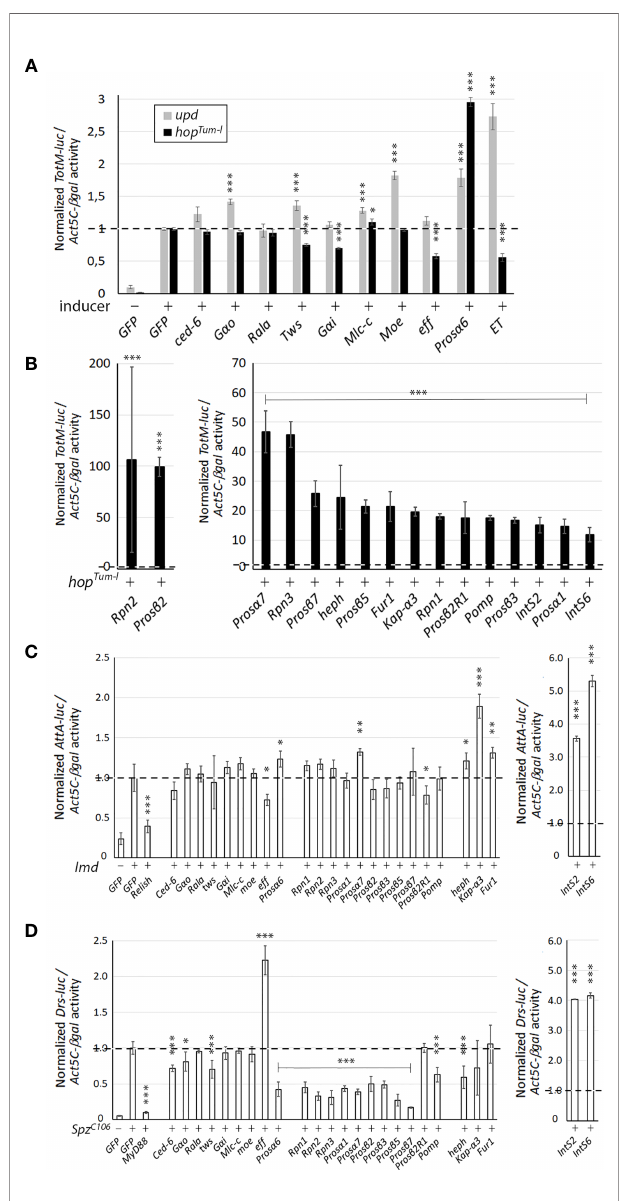
FIGURE 1 | The effect of RNAi of the putative JAK/STAT pathway regulators on the Drosophila immunity pathways. (A) The effect of RNAi of putative ET interaction partners identi fi ed in the mass spectrometry study on the activation of the JAK/STAT pathway. The JAK/STAT pathway was induced by overexpression of Upd1 (gray bars) or hop Tum-l (black bars) and the activation of the TotM-luc reporter was measured. (B) RNAi of the negative regulator candidates from the genome-wide screen in S2 cells causes hyperactivation of the pathway induced by overexpression of hop Tum-l . (C) The effect of RNAi against the candidate genes identi fi ed in A and B on the Imd-induced Imd pathway reporter ( AttA-luc ) activity. (D) The effect of RNAi against the candidate genes identi fi ed in A and B on the Spz C106 -induced Toll pathway reporter ( Drs-luc ) activity. In all reporter assays, n=4 per dsRNA treatment, and luciferase reporter values were normalized to the values of the Act5C- b gal reporter activity. The relative reporter activity value of cells with an activated pathway treated with the negative dsRNA control (GFP) is set to 1. Statistical analyses were carried out using Student t test for two samples assuming equal variances. *p, 0.05, **p, 0.01, ***p, 0.001. n.s., not signi fi